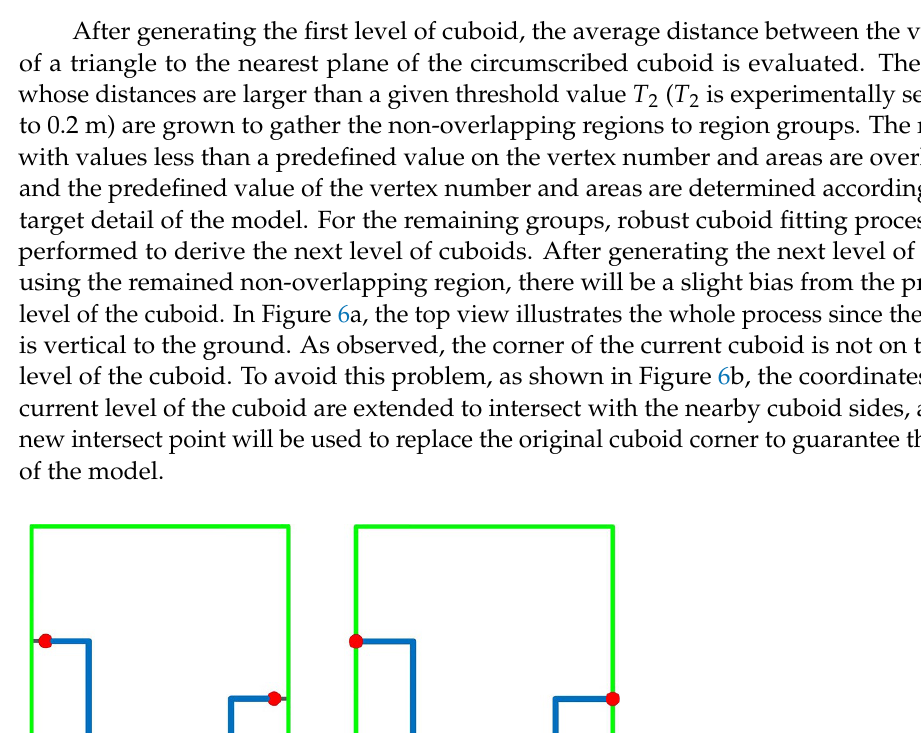
Figure 5. Illustration of the robust cuboid fitting segmentation: ( a ) top view of the model component; ( b ) fitting result. Figure 4. The workflow of the cuboid abstraction processing.